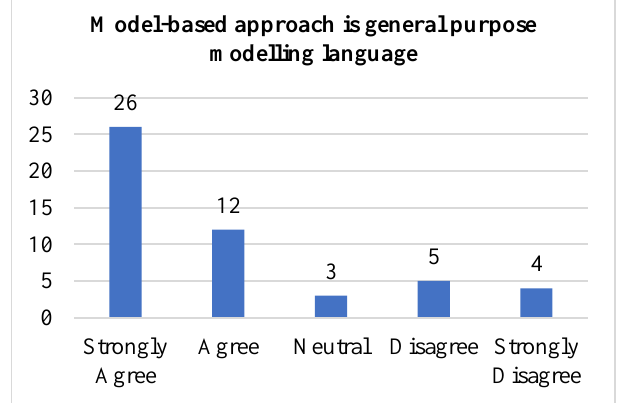
Fig. 10. UML is general purpose modelling